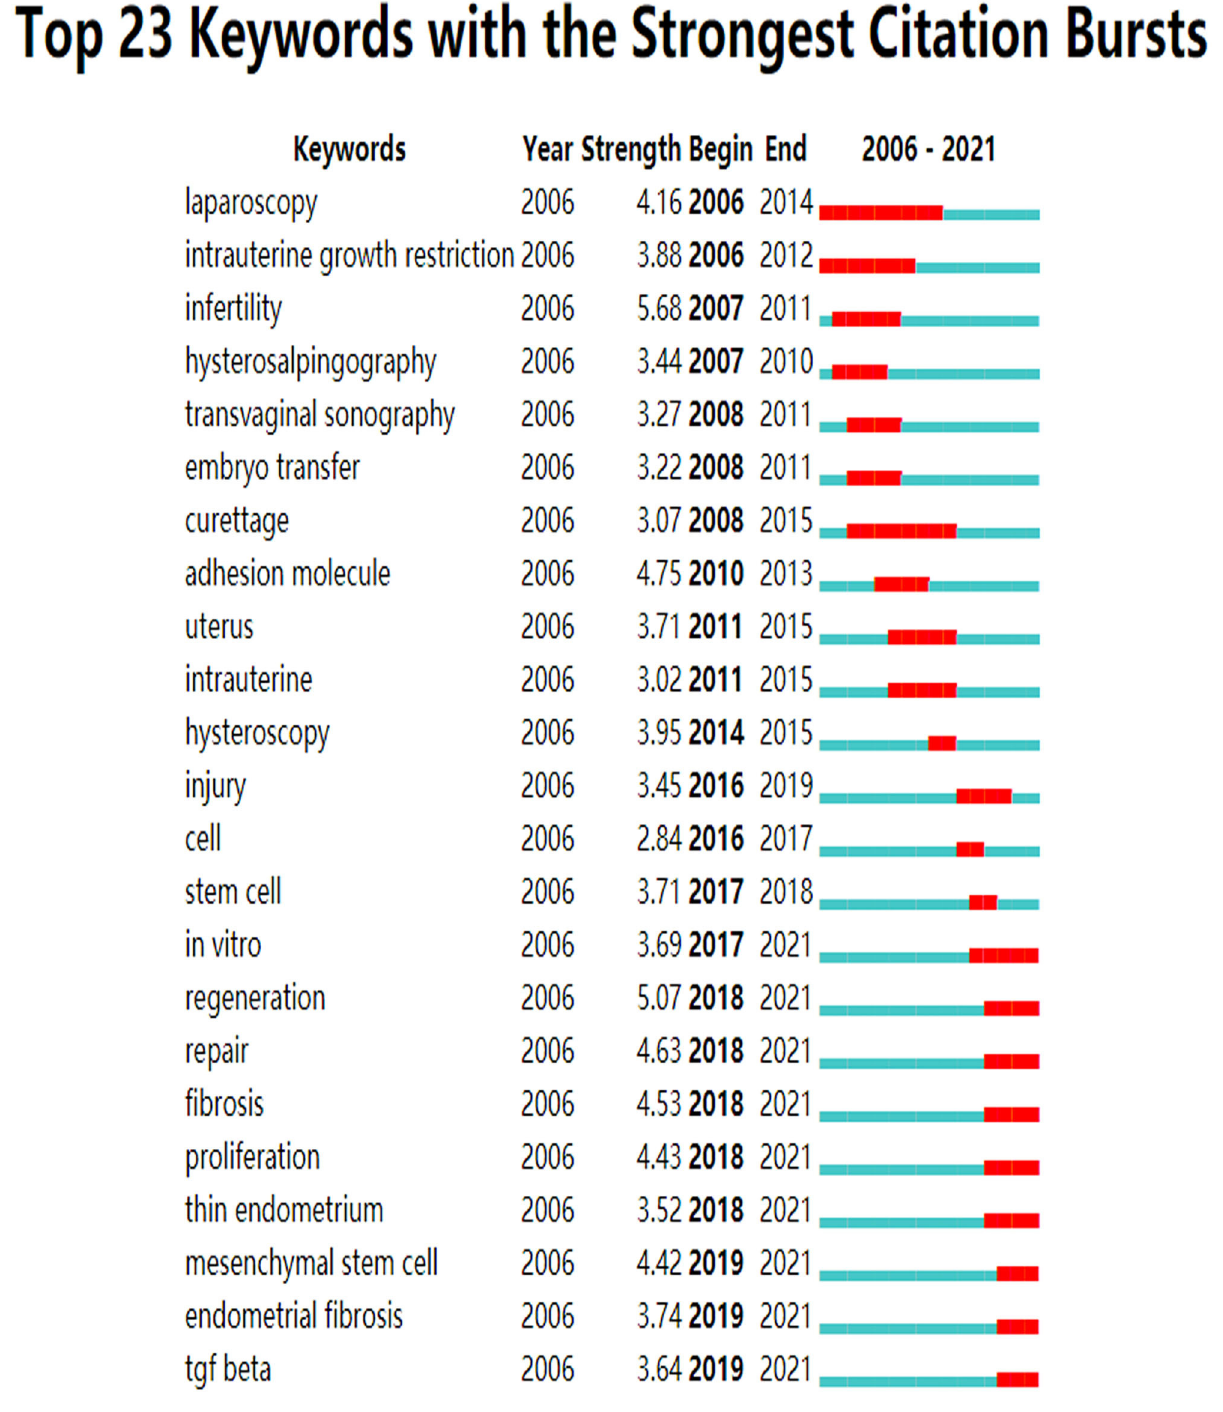
Frontiers in Reproductive Health |